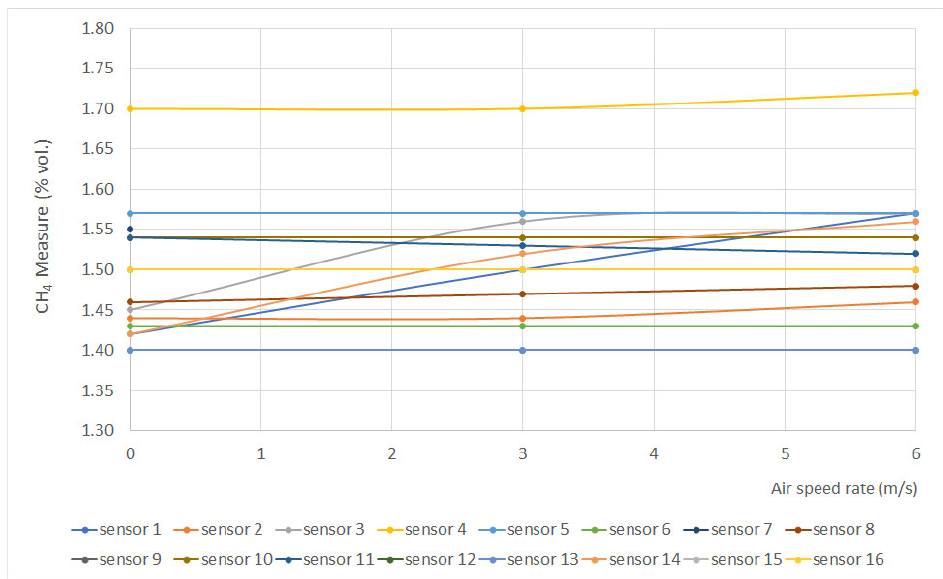
Figure 10. Air speed rate results. (Some measures present the same data, therefore some lines are overlapped).